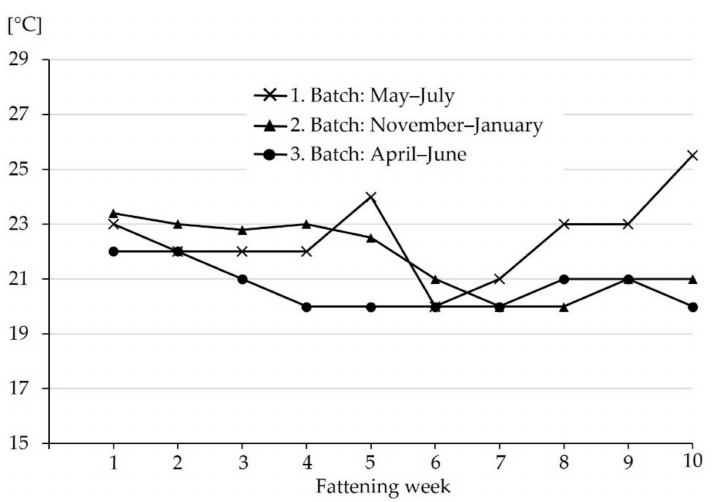
Figure 1. Indoor temperature in the different fattening weeks in the study compartment. The three different fattening periods (batches) in different seasons are